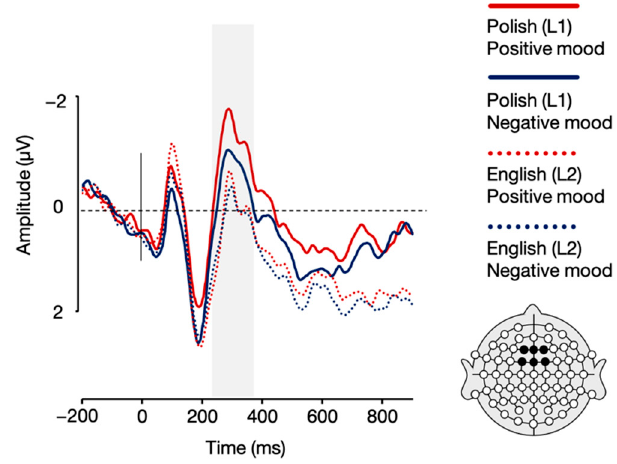
Figure 7. Grand average ERPs for Polish (L1) and English (L2) sentences in the positive and negative mood conditions over frontal (F1, Fz, F2) and fronto-central (FC1, FCz, FC2) electrodes.